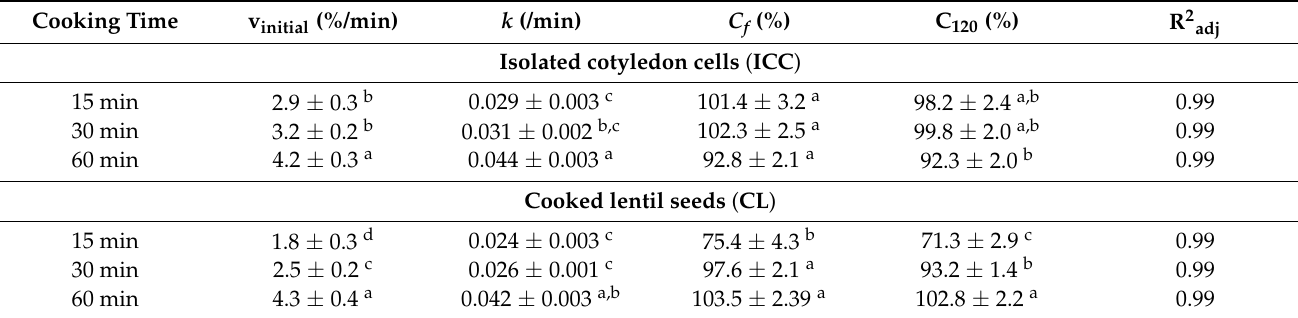
Table 2. Kinetic parameters ( ± standard deviation) estimated using the fractional conversion model (Equation (3)) for the in vitro amylolysis of whole cooked lentil seeds (CL) and isolated cotyledon cells (ICC) for different cooking times. After the rate constant k and final extent of amylolysis C f , the initial amylolysis rate (v initial ) and amylolysis extent at 120 min of the small intestinal simulation (C 120 ) were estimated. Within a column, different letters in superscript indicate significant difference between means based on 95% confidence intervals.